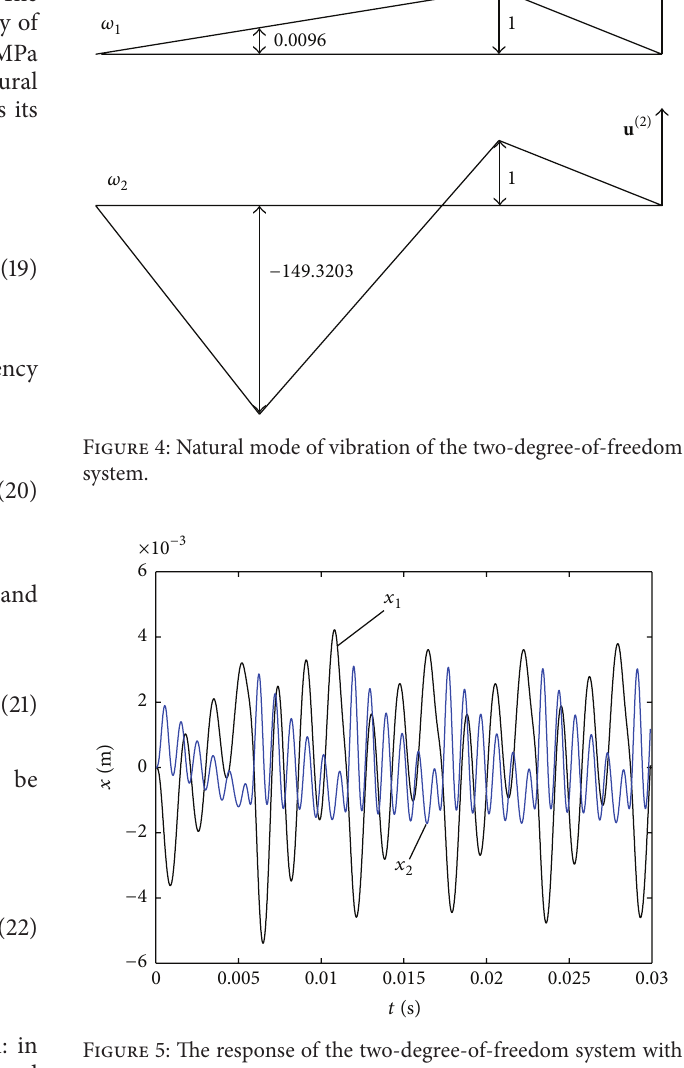
Figure 5: The response of the two-degree-of-freedom system with time 𝑡